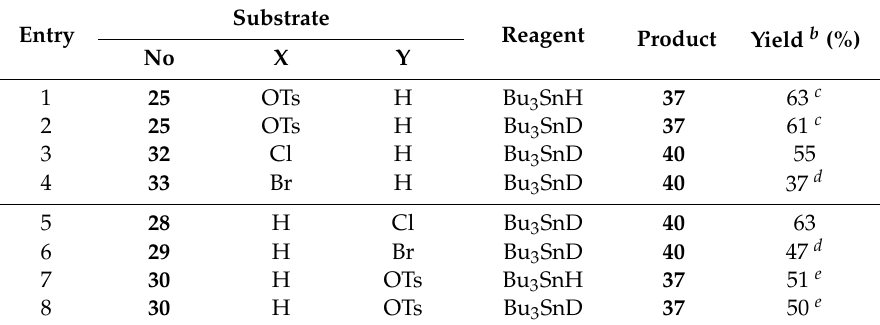
Table 2. Products from 3- O -methyl-6- O -nitro-1,4-anhydrohexitols a .